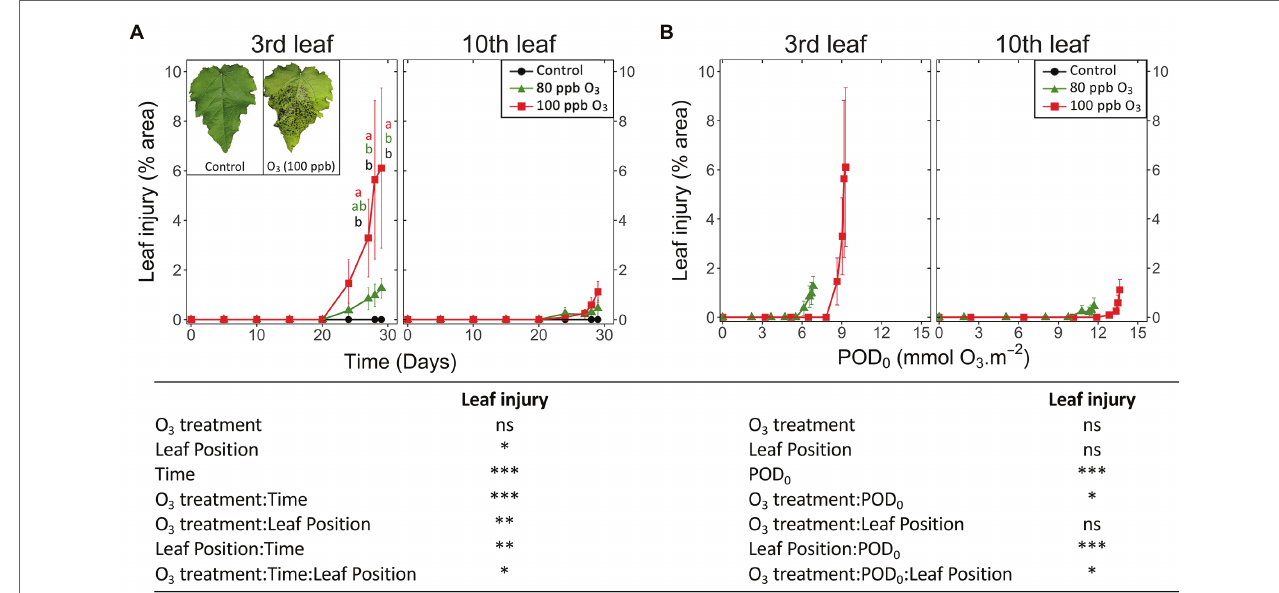
FIGURE 7 | Development dynamics of visible O 3 injury in hybrid poplar leaves ( Populus tremula x alba ), as a function of the assessment time (A) , phytotoxic O 3 dose (POD 0 ; B ), O 3 treatment (charcoal-filtered air ● , 80 ppb O 3 ▲ , 100 ppb O 3 ◼ ), leaf position and interactions {lmer[log(variable)] ~ O 3 treatment ∗ leaf position ∗ time + (1 | tree / chamber); ∗∗∗ p ≤ 0.001; ∗∗ p ≤ 0.01; ∗ p ≤ 0.05; ns, not significantly different}. The insert in (A) shows typical O 3 symptoms, in the form of intercostal necrotic dark spots, within a leaf at third leaf position exposed for 30 days (POD 0 = 9.3 mmol O 3 m − 2 , 100 ppb O 3 treatment) vs. an asymptomatic leaf from the CF treatment, sampled at the same leaf position and the end of treatment. Values represent means ± SE of leaf percentage area showing visible injury, n = 6. Letters indicate significant differences between treatments at a given assessment date ( post-hoc Tukey’s Honest significant difference, p ≤